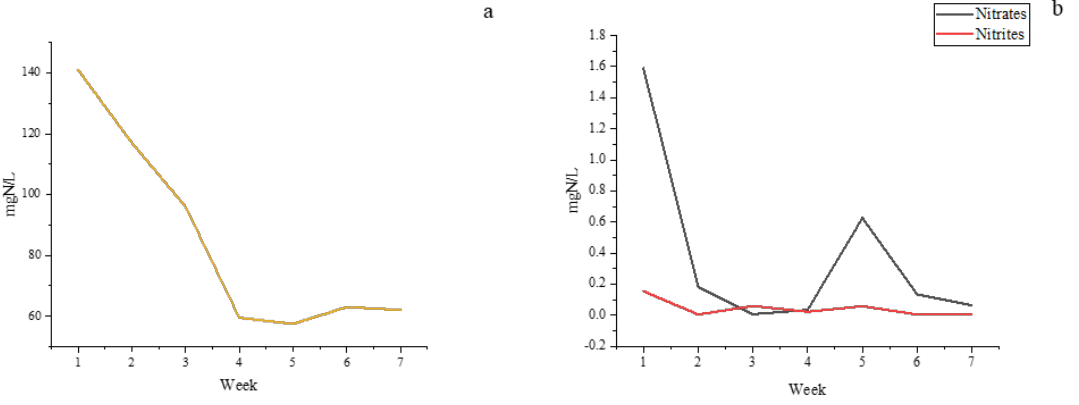
Figure 5. Changes in TKN ( a ), nitrate, and nitrite ( b ) concentration during wastewater treatment. Phosphorus and orthophosphate removal rates during the main experiment were higher compared to the preliminary experiment with values of 51.6% and 87.5%, respectively.